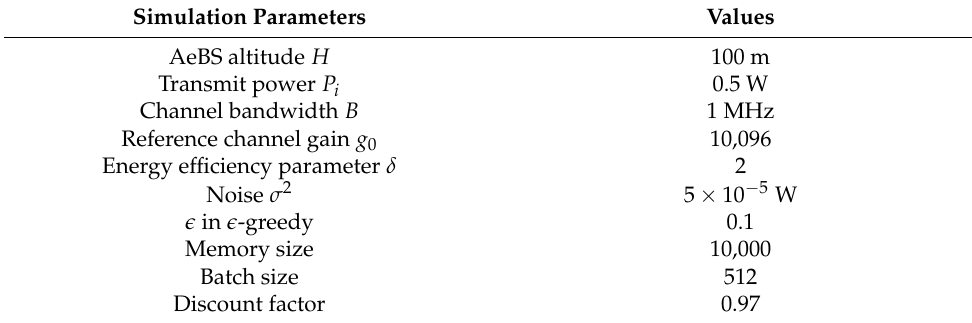
Table 2. Main simulation